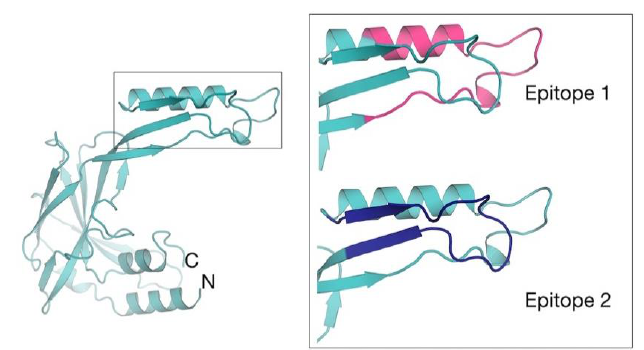
Figure 2. Structure-based Tc SMP epitope mapping. The location of computationally predicted epitopes are mapped on the crystal structure of Tc SMP. A zoom view of epitope 1 (residues 130–156; pink) and epitope 2 (residues 163–182; blue) is shown. This figure was generated using CCP4mg [54].